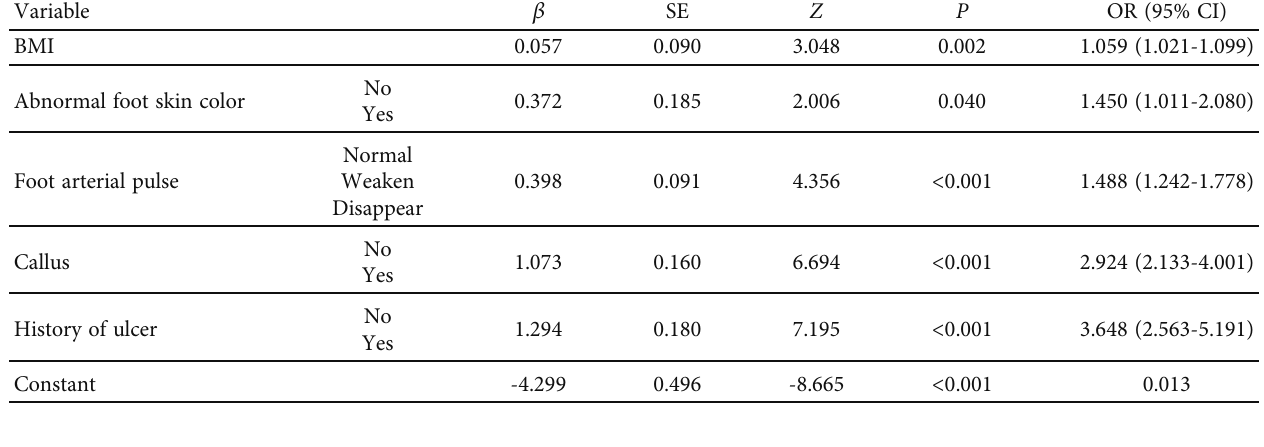
Table 1: Multivariate logistic regression analysis of diabetic foot ulcers.